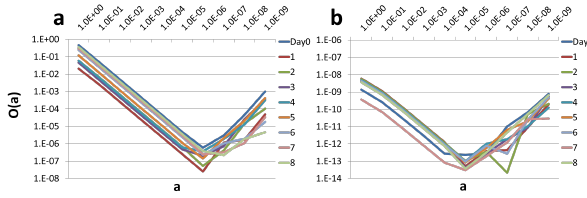
Figure 4. Linearity test for the two major modules: (a) compute_and_apply_rhs , and (b) advance_hypervis . The horizontal and vertical axes are respectively the values of the scaling factor a and the residual O( a ) for the ratio of norms in Eq. (2). The slopes with different colors show the residual O( a ) calculated at different days.